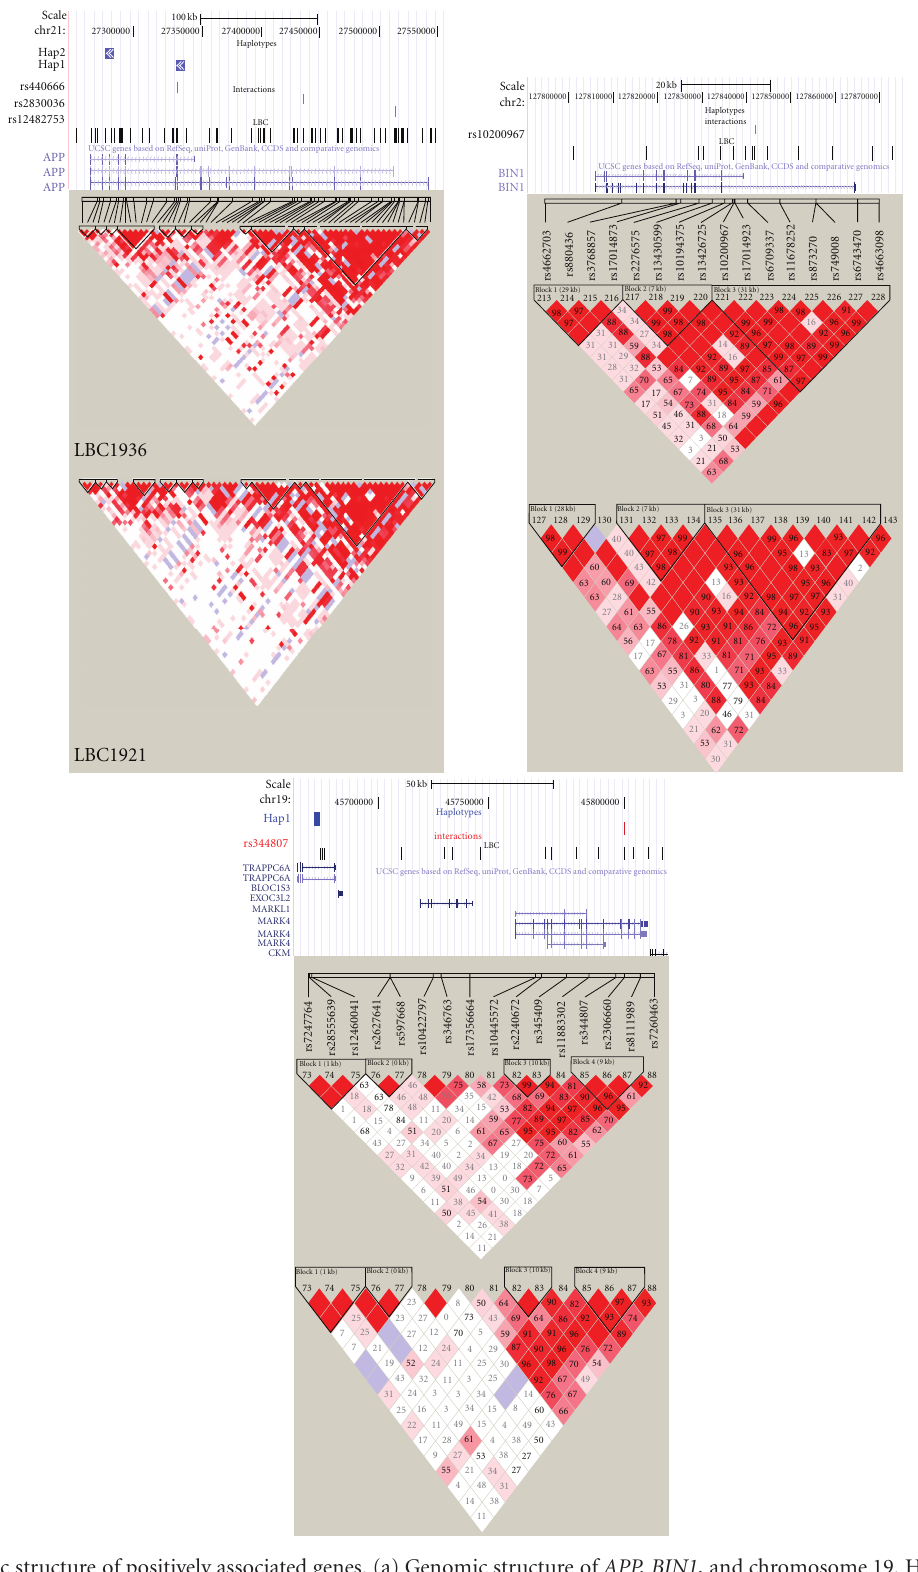
Figure 1: Genomic structure of positively associated genes. (a) Genomic structure of APP, BIN1 , and chromosome 19. Highlighted are the location of each SNP genotyped and the location of positively associated haplotypes and gene-gene interactions. (b) LD structure of APP, BIN1 , and chromosome 19 in the Lothian Birth Cohorts of 1936 (top) and 1921 (bottom). LD values used were D (cid:3)